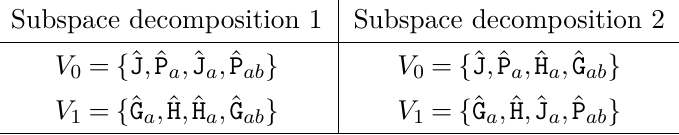
Table 3 . Subspace decompositions of the spin-3 AdS